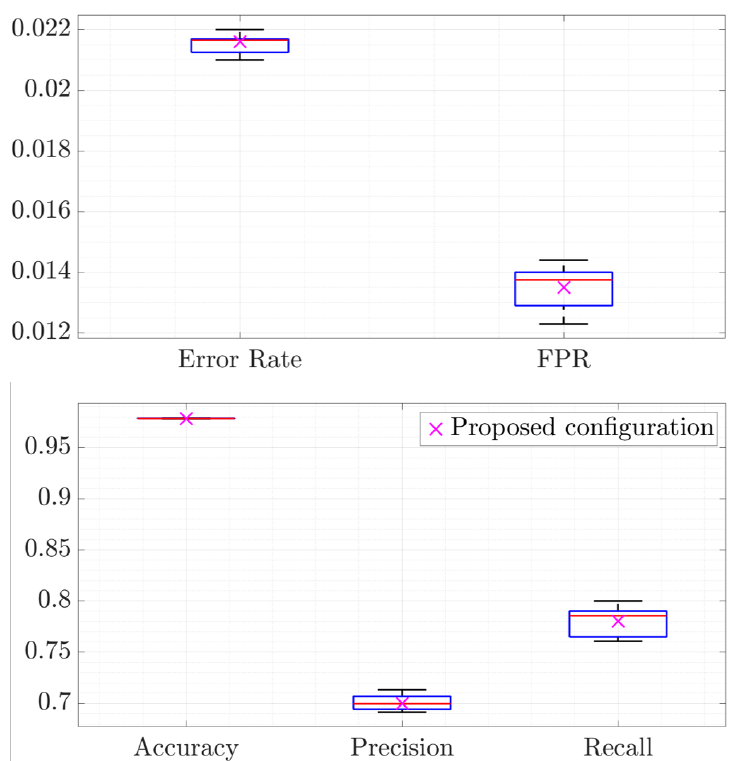
Figure 4. Performance of the proposed configuration and the rest of the configurations for the whole dataset.